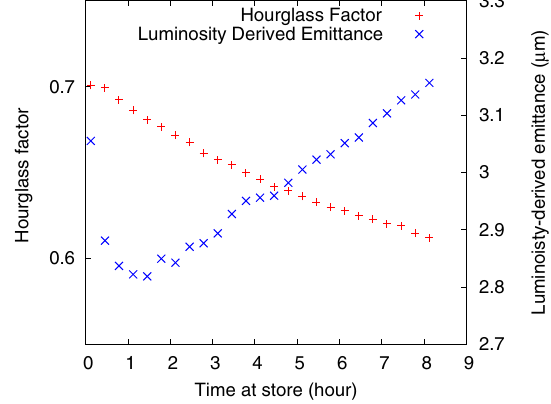
FIG. 6. Calculated hour-glass factor and luminosity-derived rms transverse emittance for Fill